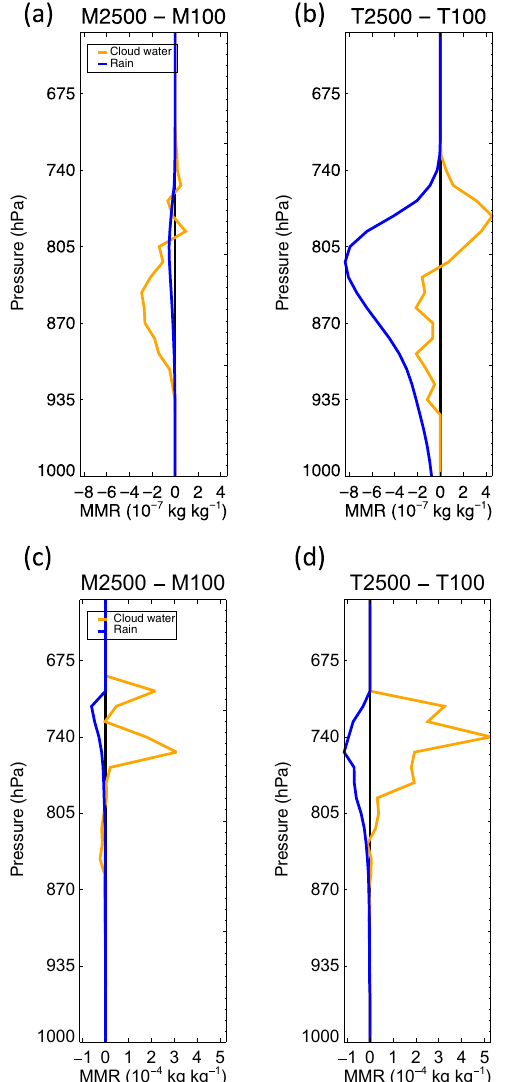
Figure 12. RICO case: difference in the mean hydrometeor mix- ing ratio profiles under polluted and pristine conditions in cloudy columns, as in Fig. 7, averaged over the 24h of the RICO sim- ulation. (a) RICO-M2500 cloudy column domain mean minus RICO-M100 domain mean, (b) RICO-T2500 domain mean minus RICO-T100 domain mean, (c) RICO-M2500 condensate mean over each hydrometeor class minus RICO-M100 condensate mean and (d) RICO-T2500 condensate mean minus RICO-T100 condensate mean.